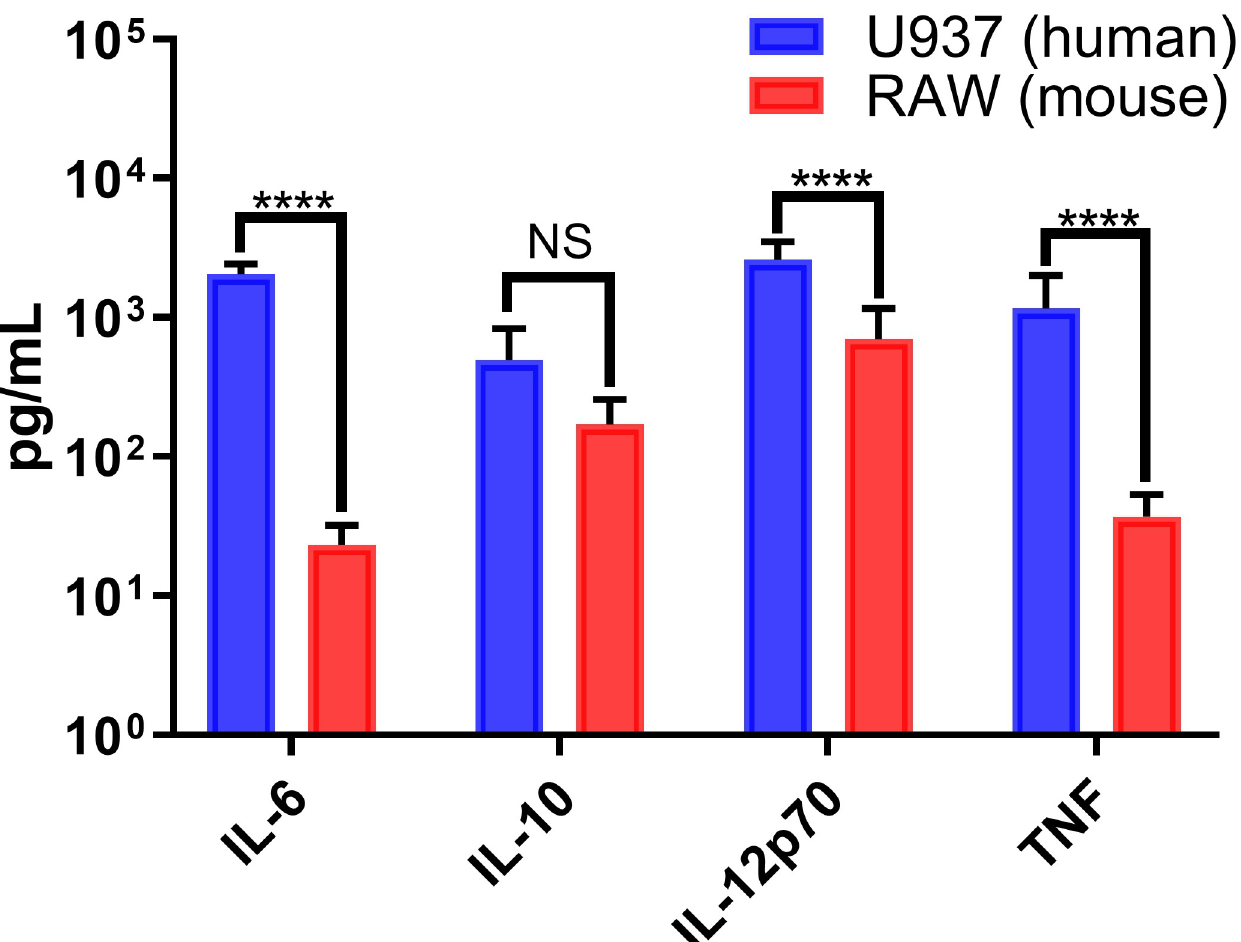
Fig 7. CHIKV-infected human macrophages show a more robust pro-inflammatory profile. Cytokine expression in CHIKV-infected human and murine macrophages was quantified by cytometric bead arrays at 24 hpi. Data show mean values of three independent experiments with a total of n = 9, MOI = 5. Statistical significance was determined using multiple t-test corrected using Holm-Sidak method. � P < 0.05; �� P < 0.01; ��� P < 0.001; ���� P < 0.0001; NS, not significant.